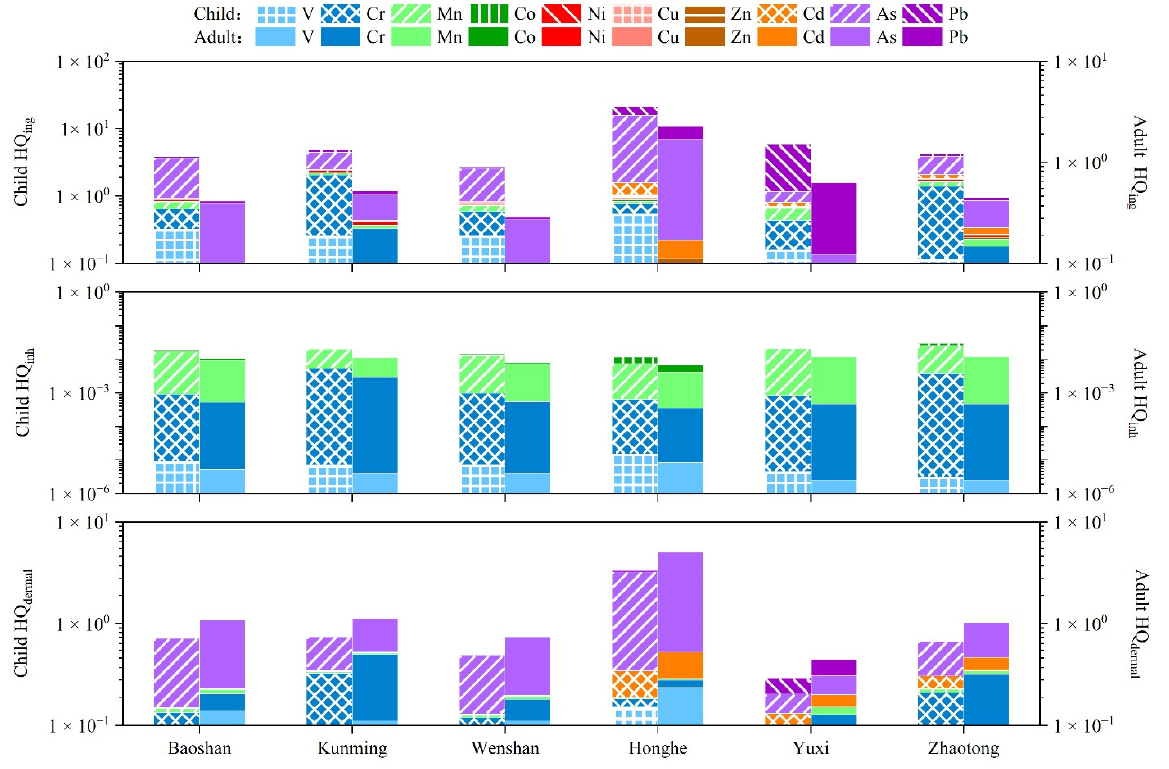
Figure 7. Non-carcinogenic risk of potentially toxic elements in PM 2.5 of soil fugitive dust.